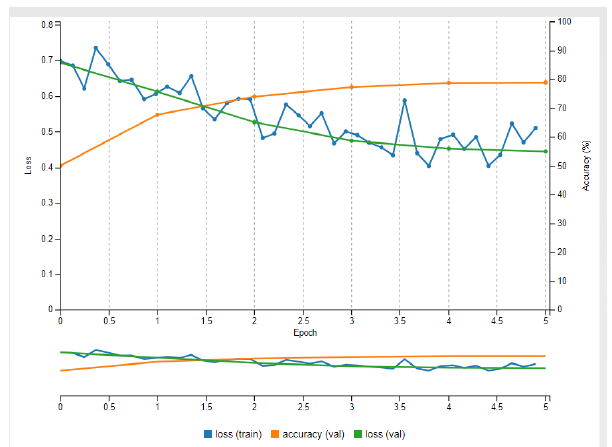
Figure 10. Performance Analysis of Loss with respect to Epoch for Training, Validation and